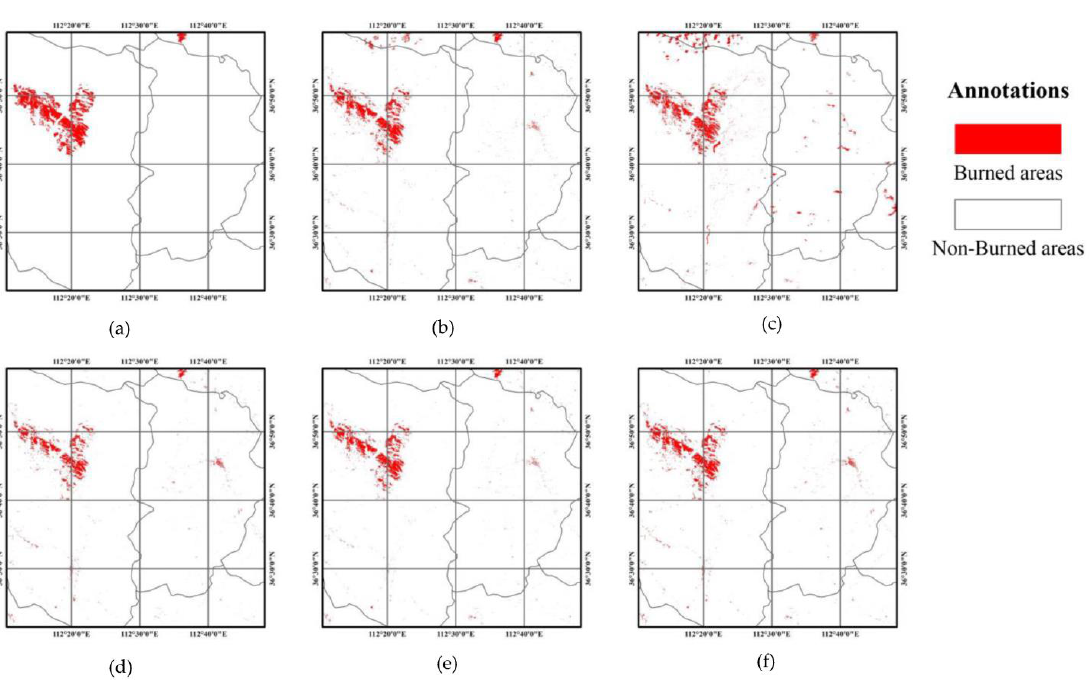
Figure 7. Burned area classification by image segmentation using respectively optimal threshold ( a ) visual interpretation; ( b ) NBR+; ( c ) BAI; ( d ) MIRBI; ( e ) ABAI; ( f ) MNBR.